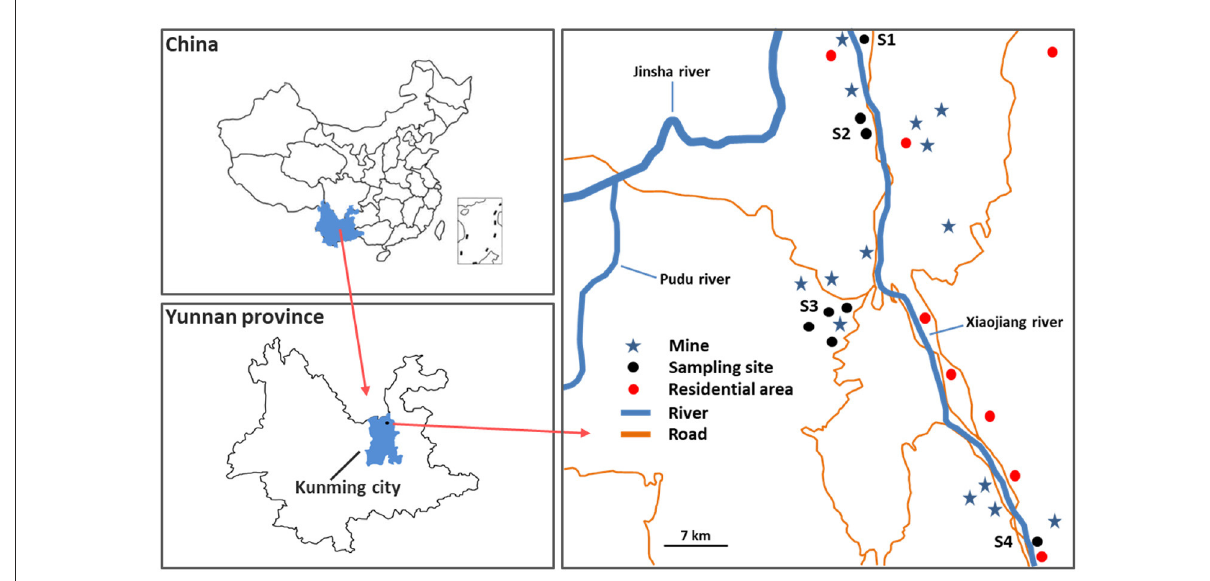
FIGURE1 Schematic display of study area and sampling